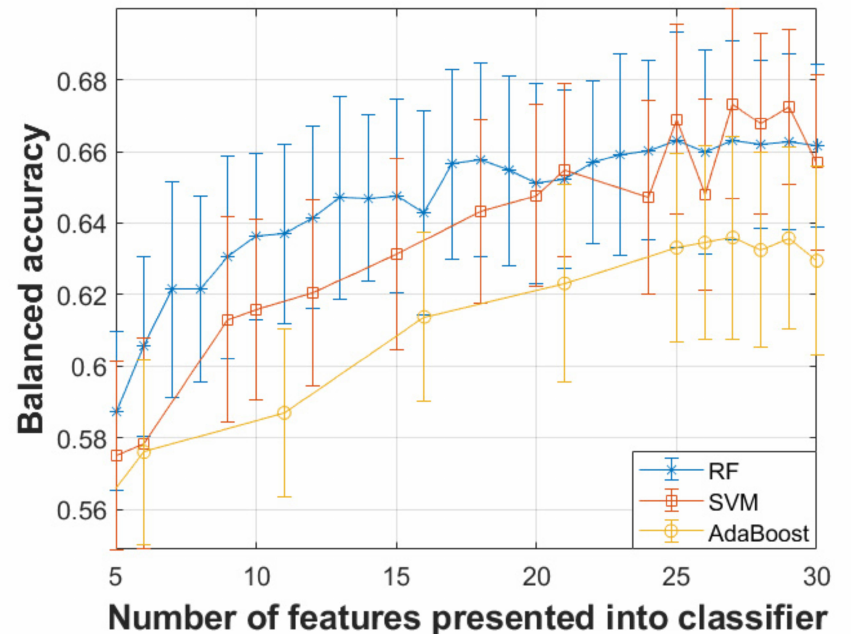
Figure 2. Balanced accuracy as a function of the number of features presented into the three binary classifiers for the validation dataset comprising 3000 samples (1500 controls and 1500 PwP). The bars denote the standard deviation around the quoted mean score. The features presented into the classifiers were selected using SIMBA.